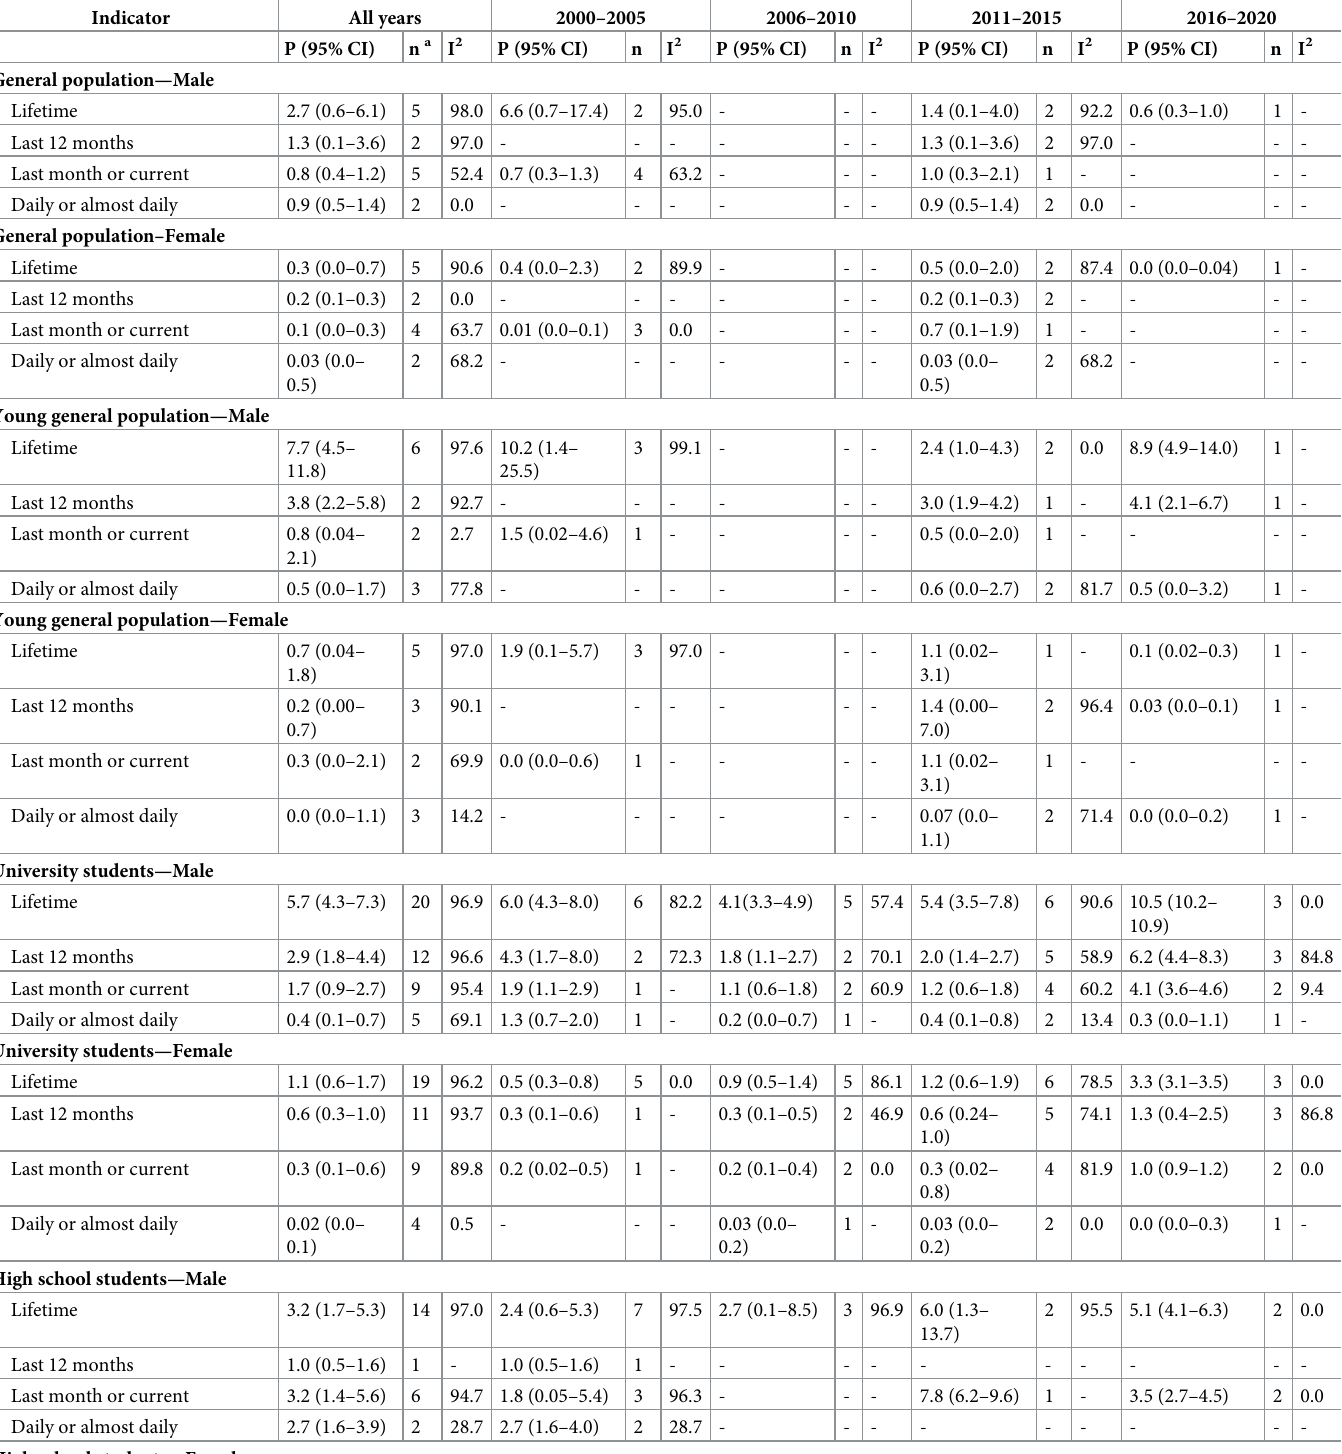
Table 5. Pooled prevalence of cannabis use through time among general population, young general population, university students, high school students, and "com- bined youth groups".